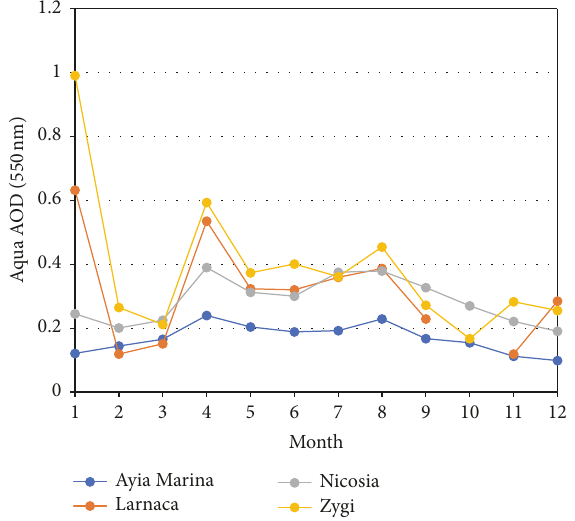
Figure 4: Monthly average values of Aqua AOD in the 2003–2005 periodcorrespondingtoeachofthefourgroundmeasuringstations.